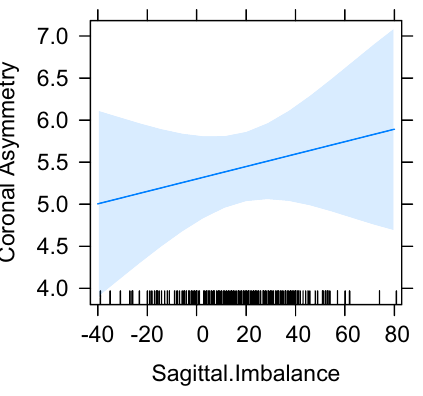
Figure 6. All effects model plot females.